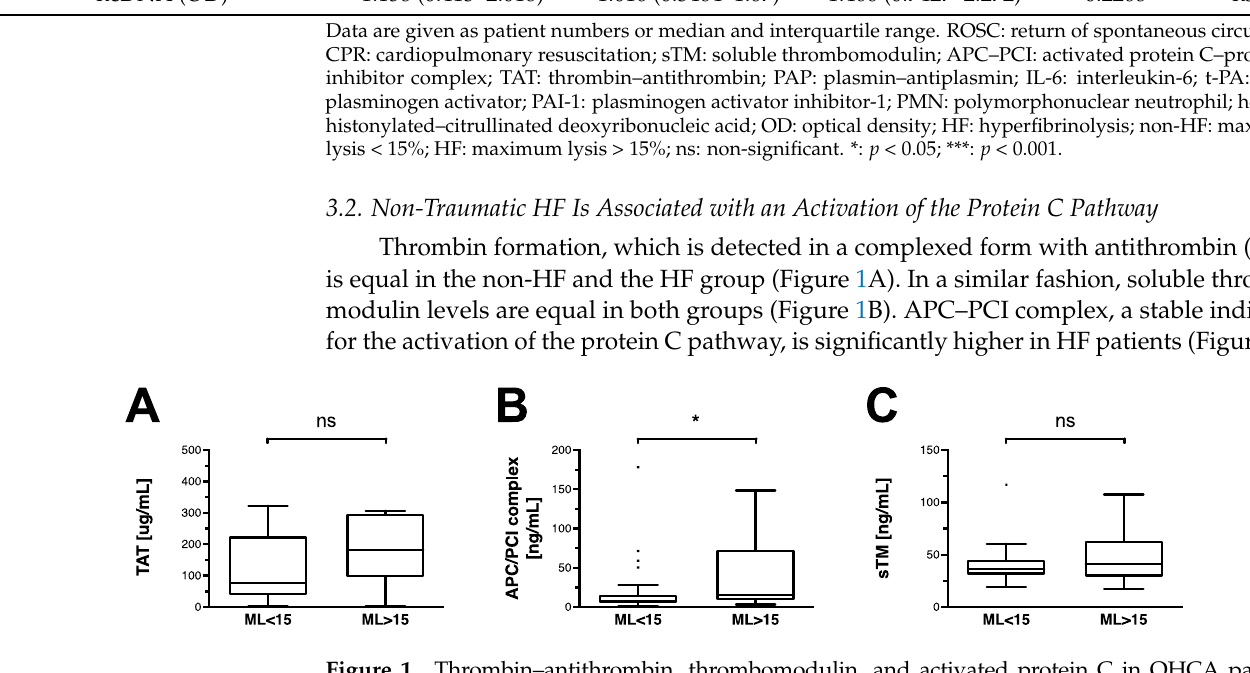
Figure 1. Thrombin–antithrombin, thrombomodulin, and activated protein C in OHCA patients. Data are shown as box and whiskers blots with Tukey-style depiction of outliers. OHCA patients were stratified by ROTEM maximum lysis (ML). Hyperfibrinolysis was defined as a ML > 15%. Parameters in patients with and without hyperfibrinolysis were compared with a Student’s t -test or Mann–Whitney test, where applicable. Comparison between ( A ) thrombin–antithrombin (TAT), ( B ) soluble thrombomodulin (sTM), and ( C ) activated protein C–protein C inhibitor (APC/PCI) complex levels in OHCA patients with and without hyperfibrinolysis. * = p < 0.05; ns = non-significant.